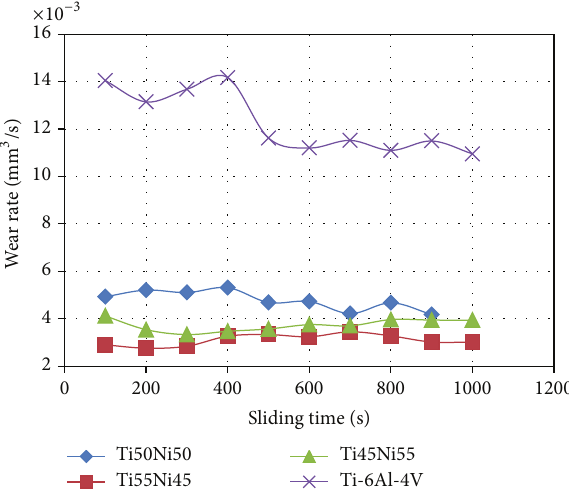
Figure 13: Wear rate analysis of laser deposited